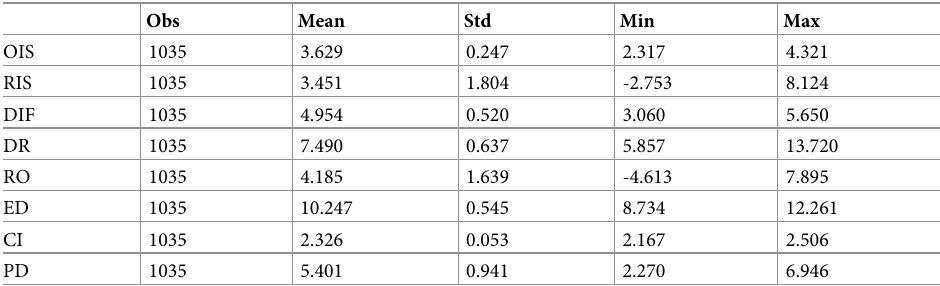
Table 2. Descriptive statistics of variables.